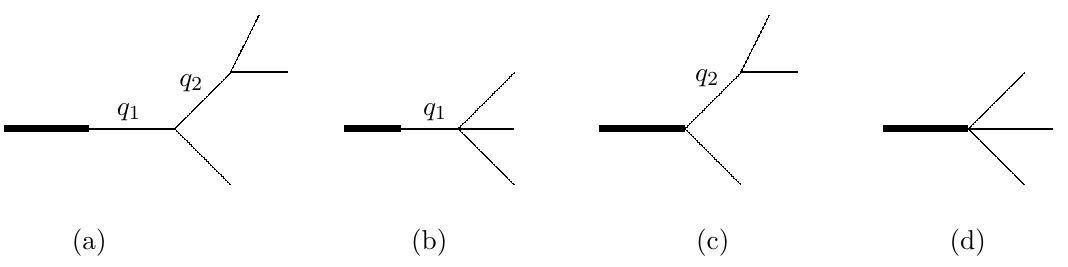
Figure 5 . The four Feynman diagrams that contribute to the C-O-O-O amplitude. This is needed to evaluate the field-dependent relationship between the string field theory gauge parameter and the rigid gauge parameter that rotates the phase of an open string field with one end on the instanton. Figure adapted from